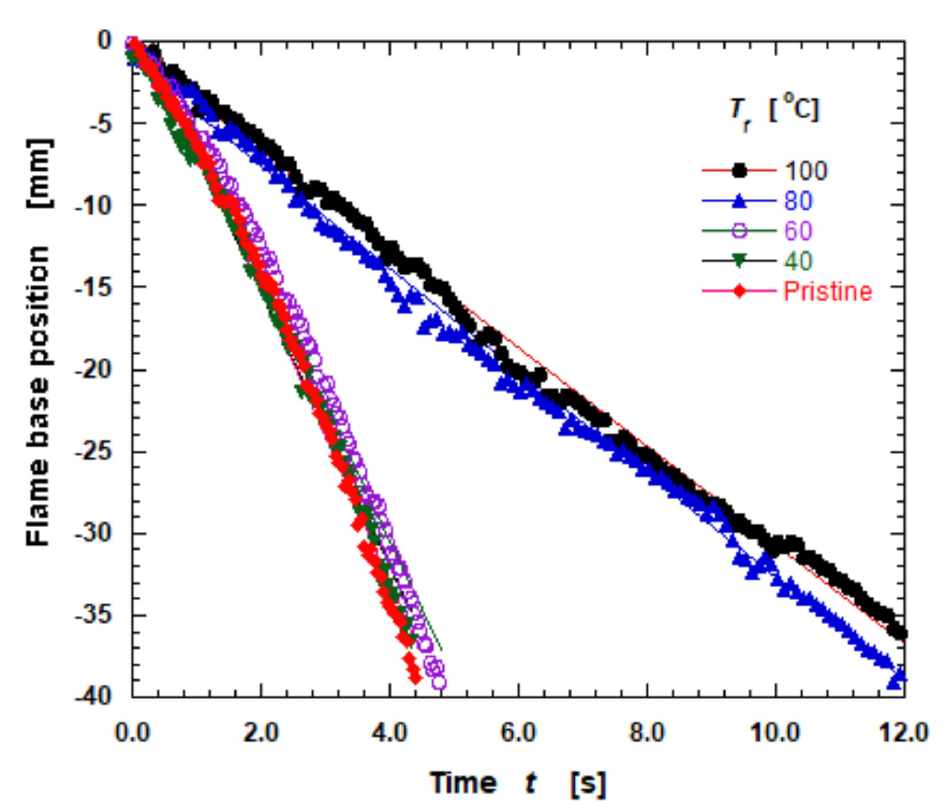
Figure 9. Temporal location of the flame base along the vertical PET–PEN